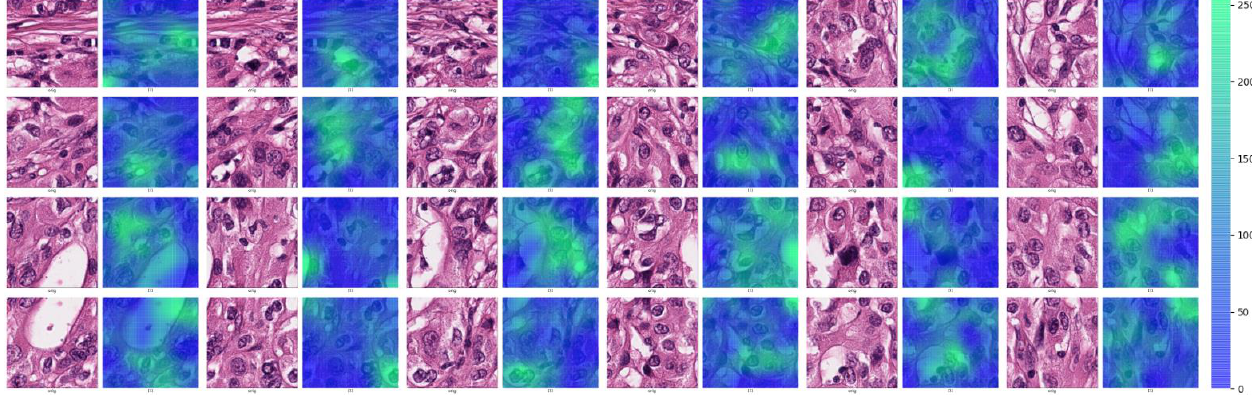
Figure 8. Attention maps of TERT -positive cases on the CRNN